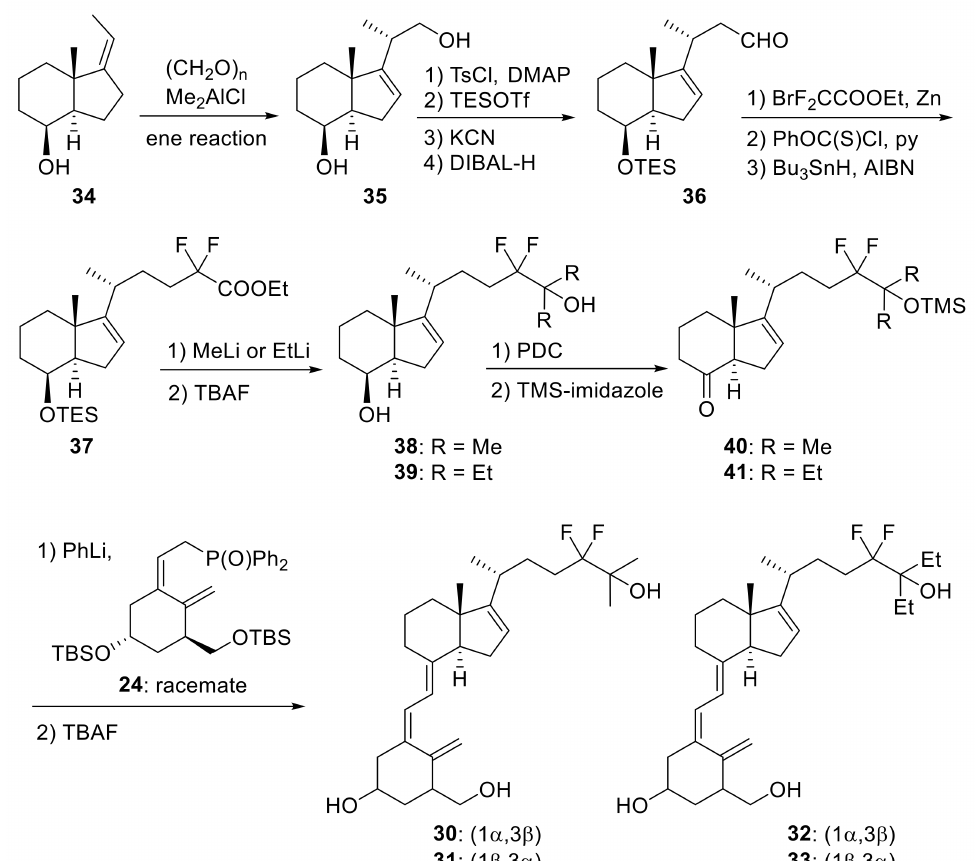
Scheme 5. Synthesis of 24,24-difluoro-16-ene-1-hydroxymethyl-25-hydroxyvitamin D 3 ( 30 – 33 ).